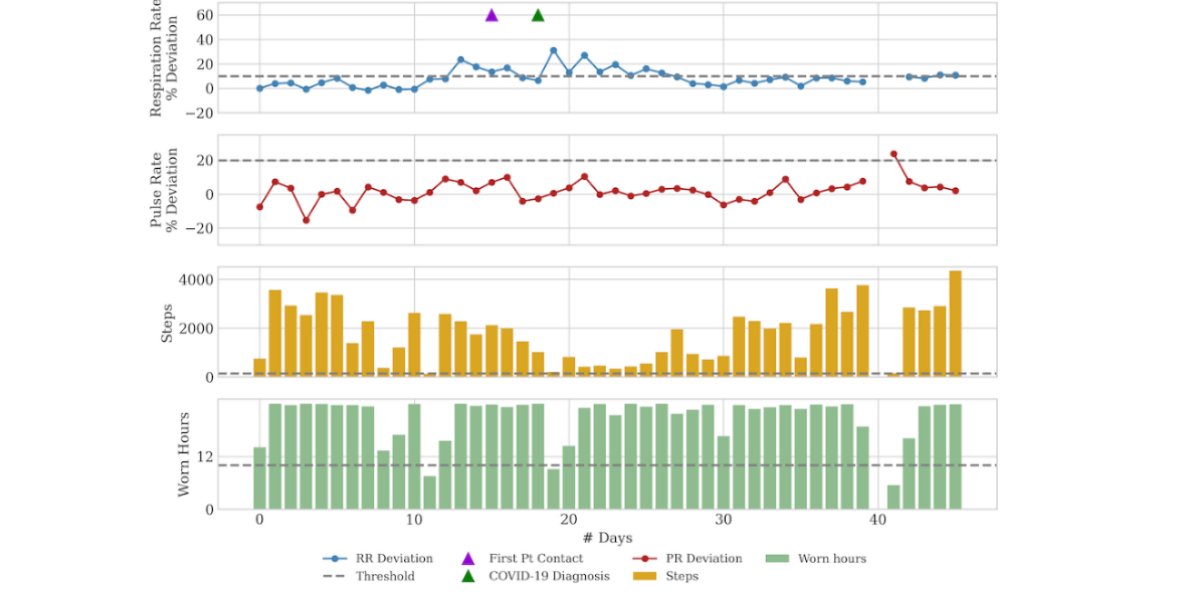
Figure 2. Daily physiology, activity, and adherence metrics for Case 2. COVID-19 diagnosis was confirmed 3 days after the patient was contacted and 5 days after initial remote patient monitoring notification. PR: pulse rate; Pt: patient; RR: respiratory